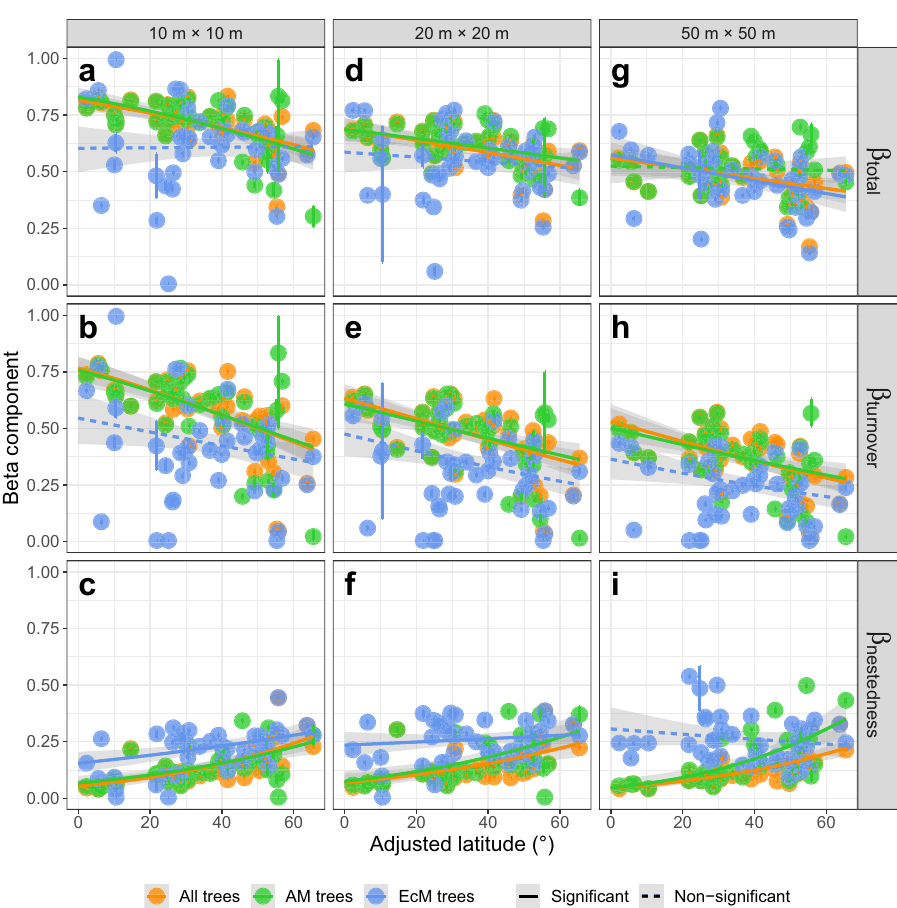
Fig. 2 Latitudinal gradients in tree beta-diversity. Total beta-diversity, species turnover, and species nestedness of all trees, AM trees, and EcM trees across latitudes at quadrat scales of 10 m × 10 m ( a – c ), 20 m × 20 m ( d – f ), and 50 m × 50 m ( g – i ). Orange points represent total beta-diversity and its two components (species turnover & nestedness) of all trees and orange lines represent their latitudinal patterns. Green points represent total beta-diversity and its components of AM trees and green lines represent their latitudinal patterns. Blue points represent total beta-diversity and its components of EcM trees and blue lines represent their latitudinal patterns. Points are the mean values and the error bars are the 95% con fi dence intervals, estimated using the non-parametric bootstrapping method ( n = 200). In total, 200 replicates of average pairwise beta-diversity and its components were calculated based on 30, 15, and 15 randomly sampled quadrats of 10 m × 10 m, 20 m × 20 m, and 50 m × 50 m from each forest plot, respectively. Solid lines indicate signi fi cant relationships with latitude whereas dashed lines indicate non-signi fi cant relationships fi tted using the beta regression. The error bands (shaded areas) are the 95% con fi dence intervals of the fi tted relationships, with sample size n = 45 for all trees, n = 44 for AM trees, and n = 43 for EcM trees at the 10 m × 10 m scale; with n = 45 for all trees, n = 44 for AM trees, and n = 44 for EcM trees at the 20 m × 20 m scale; and with n = 41 for all trees, n = 40 for AM trees, and n = 41 for EcM trees at the 50 m × 50 m